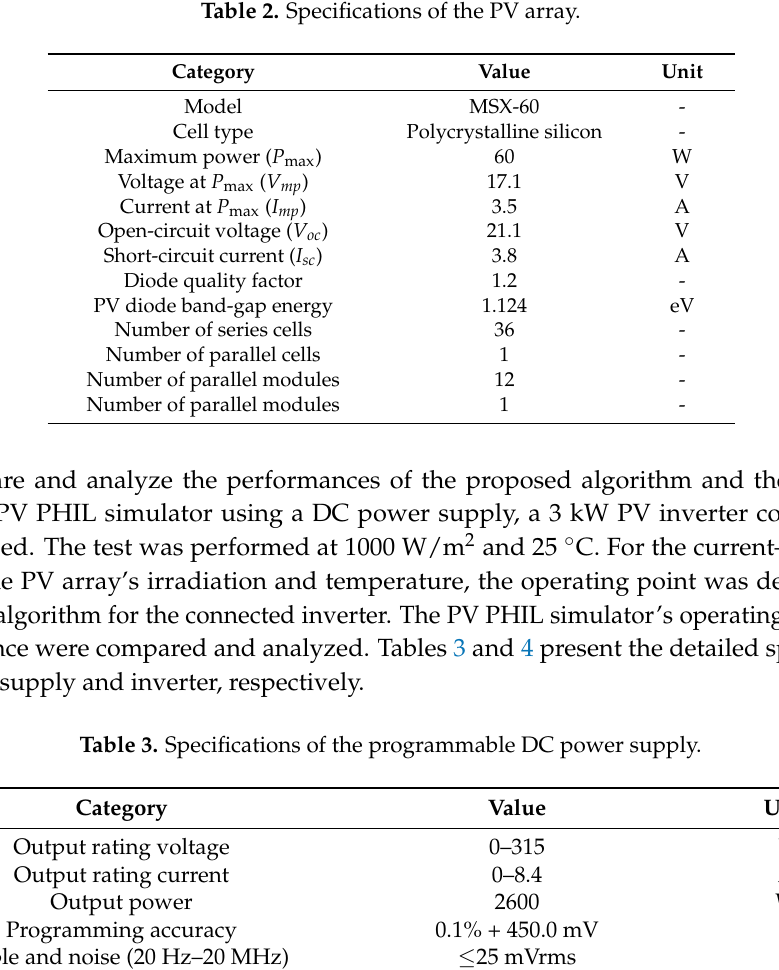
Table 2. Specifications of the PV array.